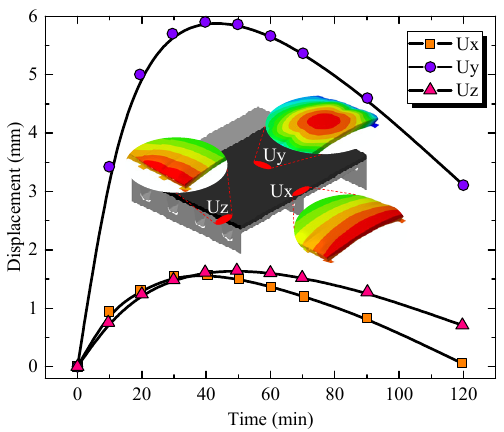
Figure 15. Variation of the maximum displacement of OSD along X-, Y-, and Z-axes.